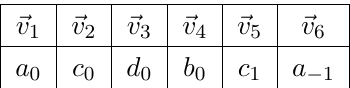
Table 2 . Relation between toric data (4.94) and perfect matchings for the Q 1 ; 1 ; 1 singularity